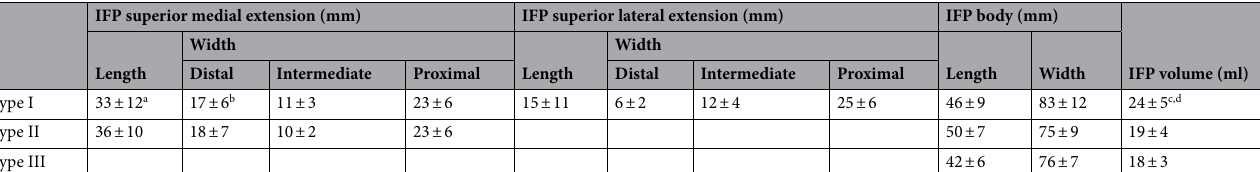
Table 2. Morphological characteristics of the IFP. Values represent mean ± standard deviation. a p = 0.002 vs. length of IFP superior lateral extension. b p < 0.001 vs. distal width of IFP superior lateral extension. c p =